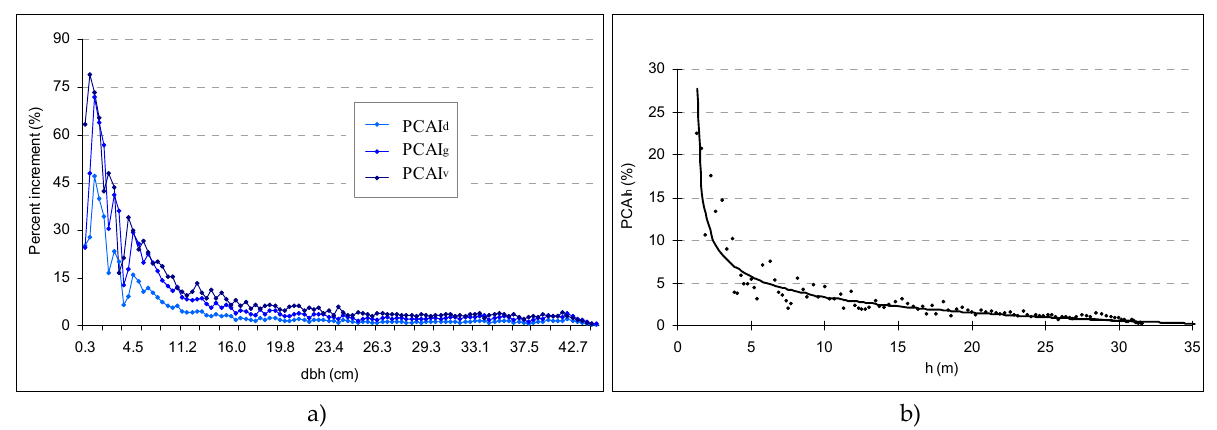
Figure 1. Percentages of mean fir tree increment: ( a ) percentage of diameter annual increments, basal area and volume (determined by Pressler’s formula); ( b ) percentage height increment of the mean tree by Equation (5) (in relation to the height of the mean tree at the end of the chosen period).